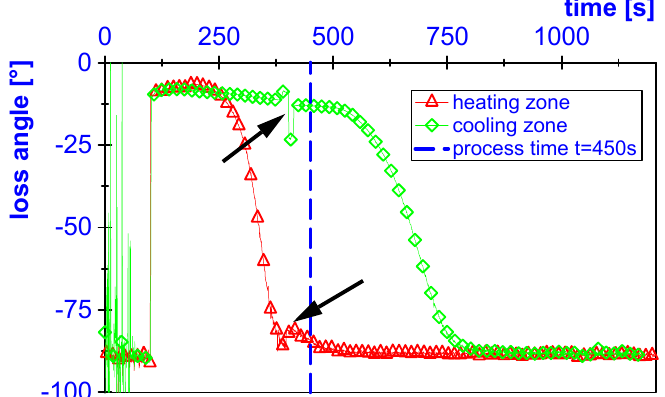
Figure 7. Loss angle measurement at the outer heated location and at the inner cooled position. The dashed line marks the aimed deep drawing start-time at 450s. The arrows mark discontinuities in the curves resulting from AFU processing.